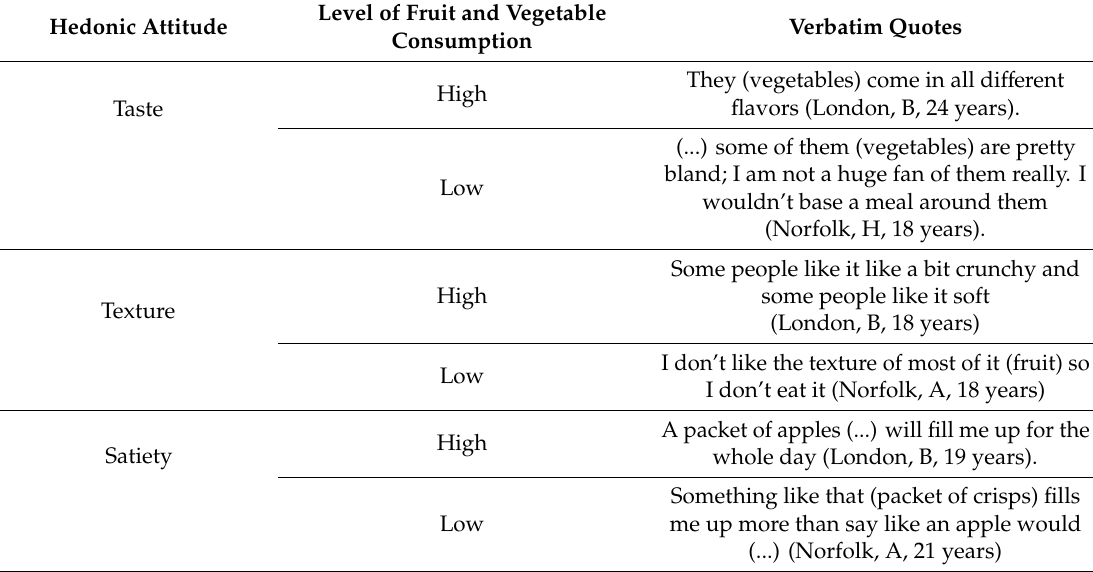
flavors (London, B, 24